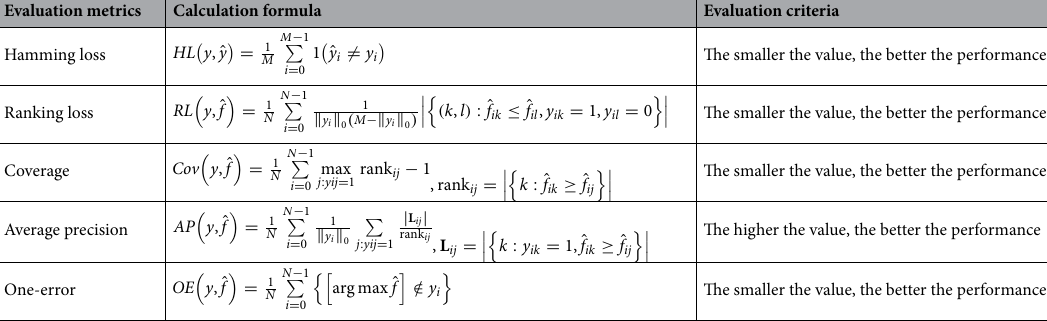
Table 1. Performance evaluation metrics of the RVMFL diagnosis model.